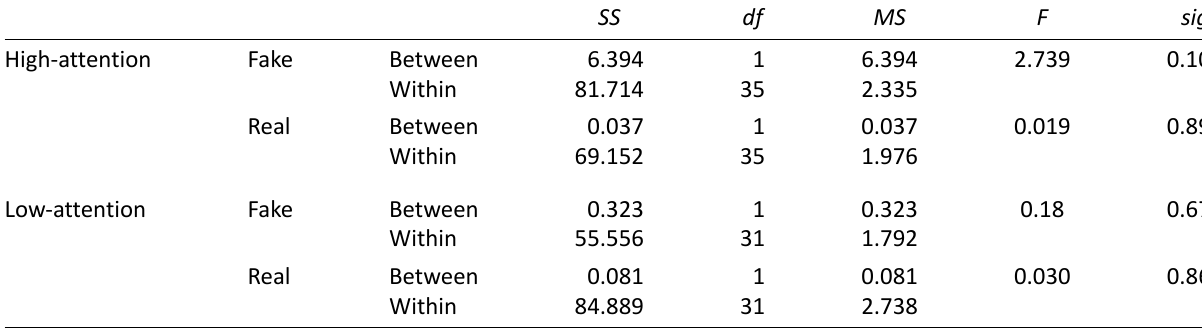
Table 8. ANOVA on the effect of place of origin on information judgment. SS df MS F sig High‐attention Fake Between Within Real